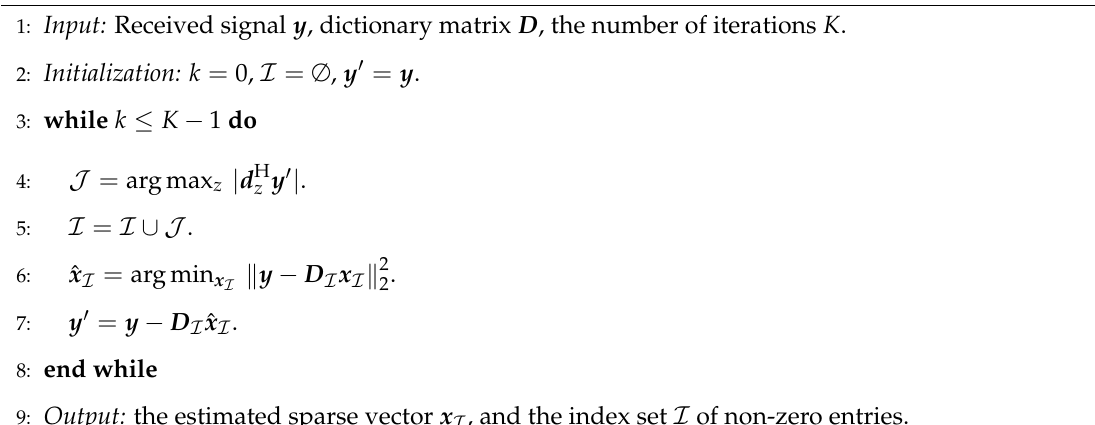
Algorithm 1 OMP algorithm for DoA and DoD estimation